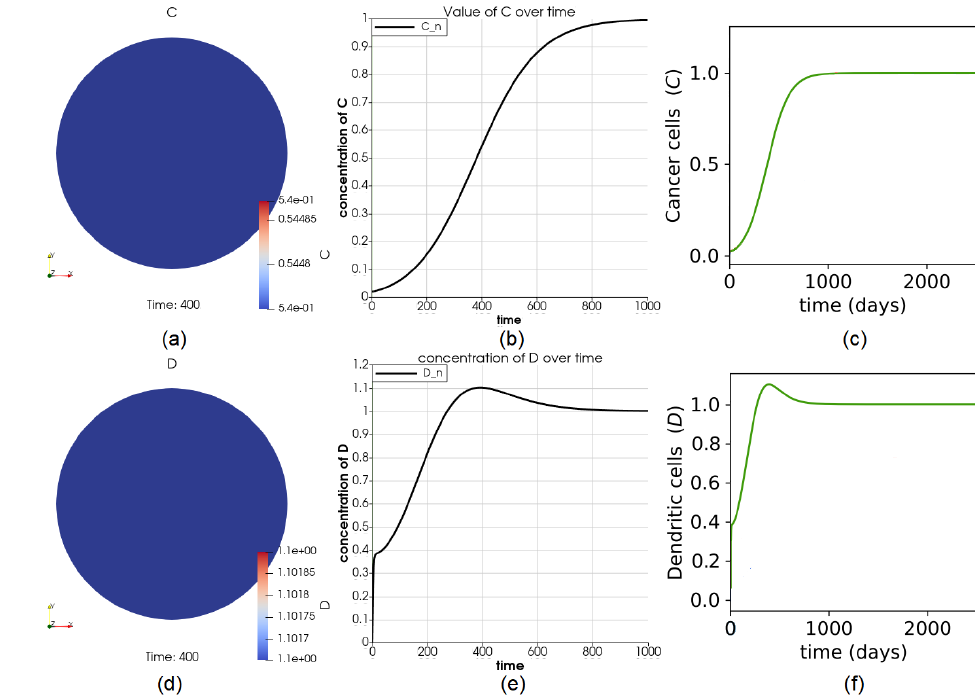
Figure 2. Dynamics of variables C and D . Part ( a ) shows the value of C at time t = 400 for the first group of osteosarcoma patients provided in [12]. The agreement of the curve in ( b ) with the green curve (results of the first group of tumors) from ( c ) shows that the dynamics of C at any point in the domain match the solution from the ODE paper. Sub-figure ( d – f ) show the dynamics of D .